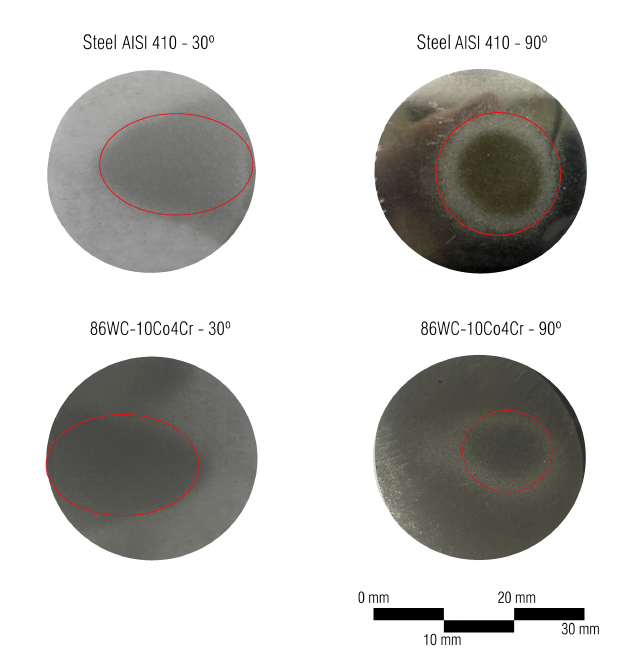
Figure 11. Eroded regions of the materials submitted to the jet slurry test obtained by Image J software (LM, 50 × ).